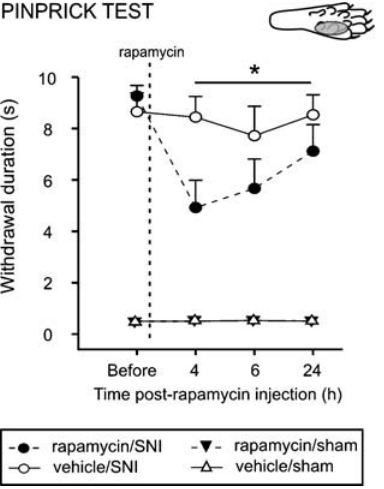
Figure 8. Rapamycin attenuates mechanical pinprick hyperal- gesia in the spared nerve injury (SNI) model. Effect of lateral intraplantar injection of rapamycin, or its vehicle, on withdrawal response duration (s) after nociceptive mechanical stimulation (pinprick stimulus) of the lateral plantar surface of the paw of SNI animals, or sham animals. Mean 6 SEM is illustrated. N=6–9 in each group. * P , 0.05.